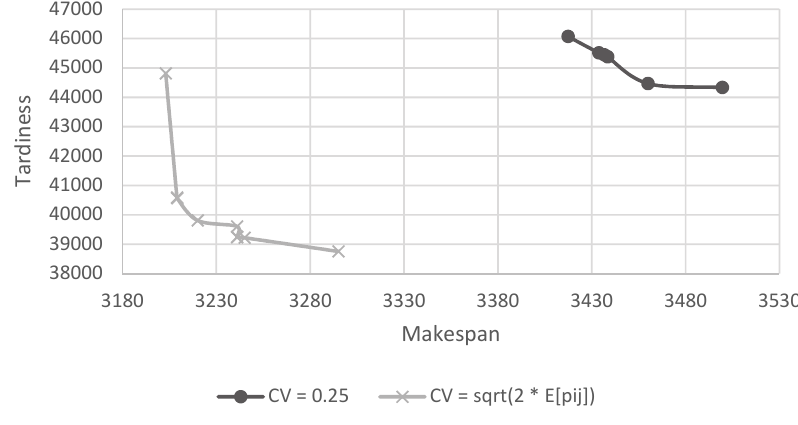
Fig. 8. Pareto fronts of Taillard’s instance 46 (50 jobs × 10 machines)